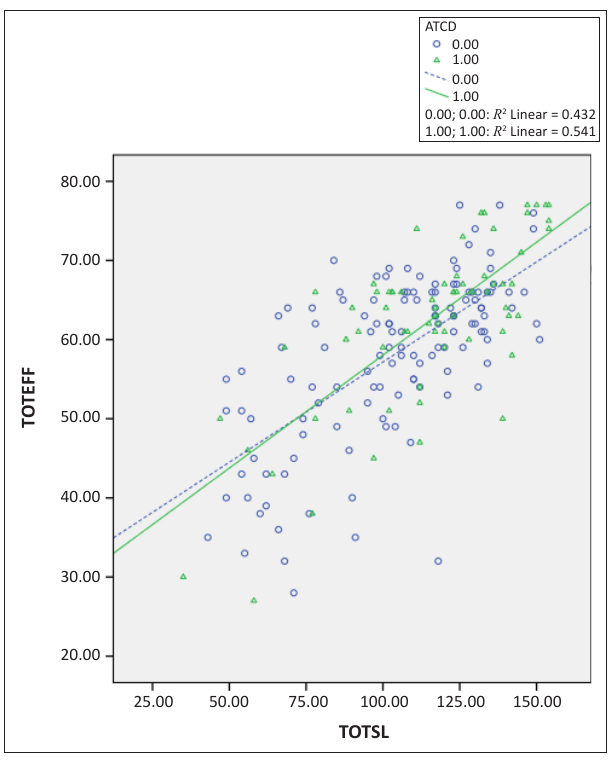
FIGURE 2: The scatter plot of the interaction effect of affective team commitment on servant leadership and team effectiveness.